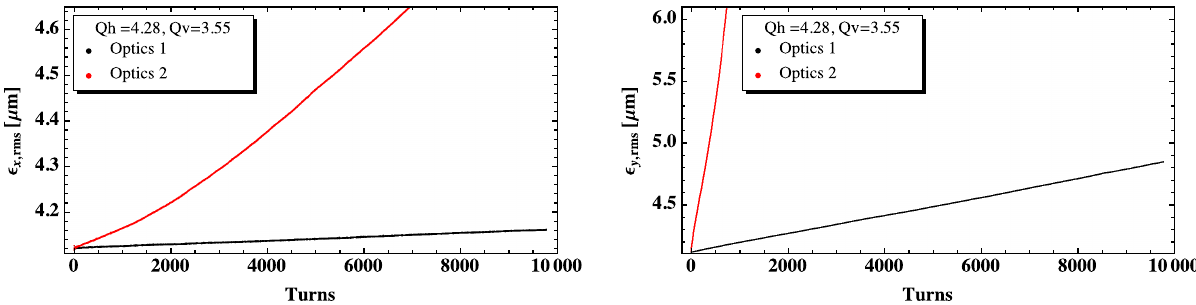
FIG. 15. Time evolution of horizontal (left) and vertical (right) rms emittance for Optics 1 and Optics 2 of the 16-cell FODO lattice with onefold symmetry and a working point of Q x =Q y ¼ 4 . 28 = 3 . 55